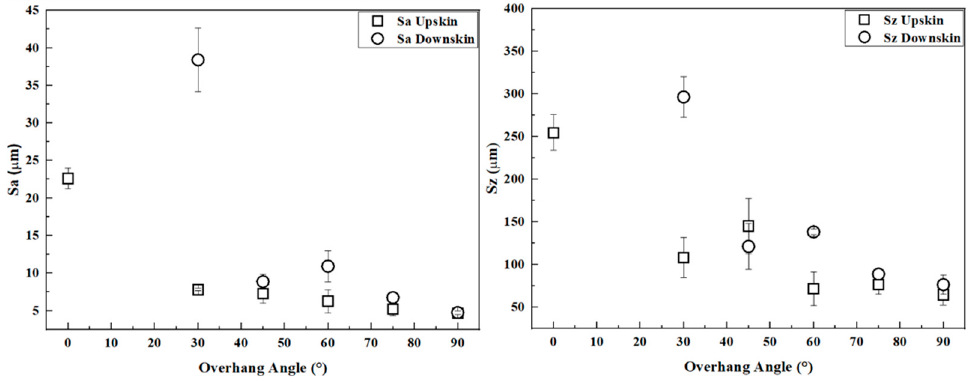
Figure 6. Sa and Sz plots reporting the mean values of the parameters measured for the different overhanging elements of the three self-supported L-PBF structures (standard deviation is indicated as ± σ ).